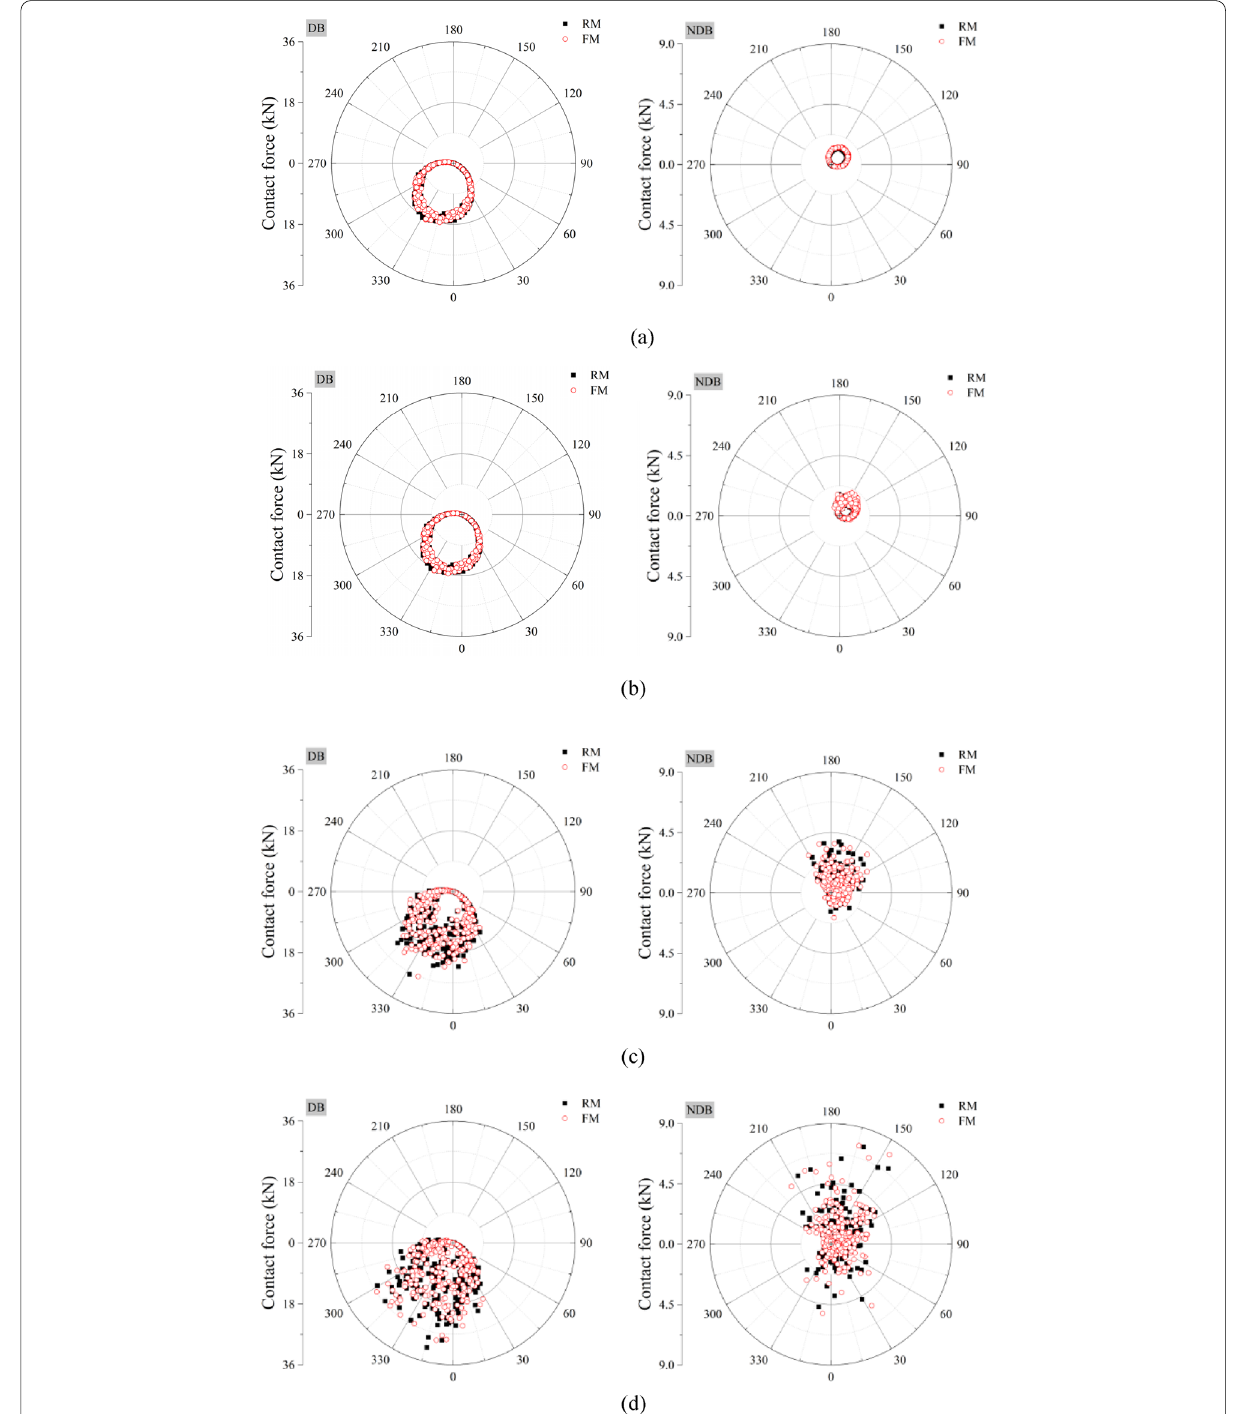
Figure 11 Effect of track irregularity on roller-race contact of driving and non-driving end bearings: a Case 1, b Case 2, c Case 3 and d Case